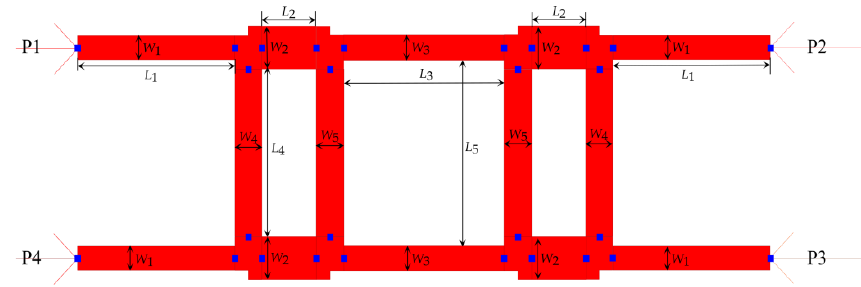
Figure 8. Layout of the type-1 crossover in